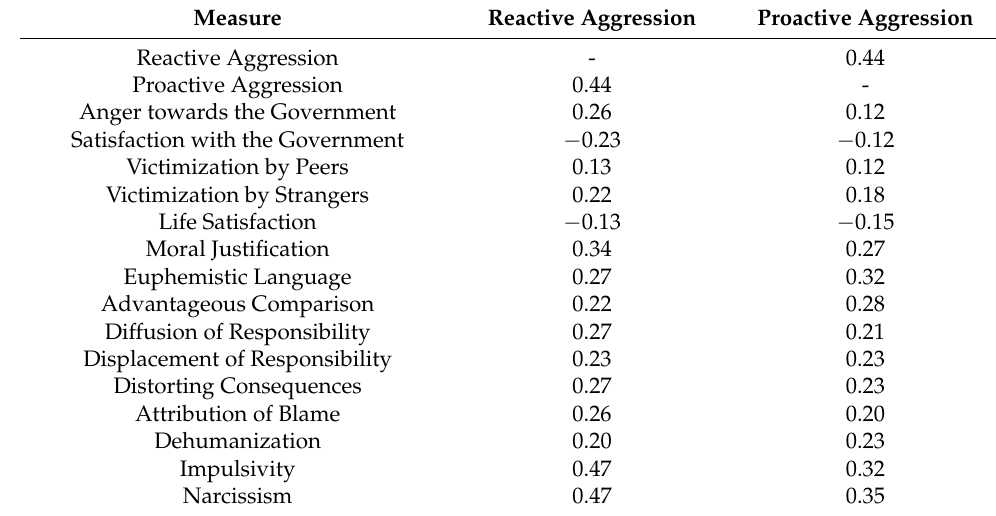
Table 3. Correlation of Two Subtypes of Aggression with Other Psychosocial